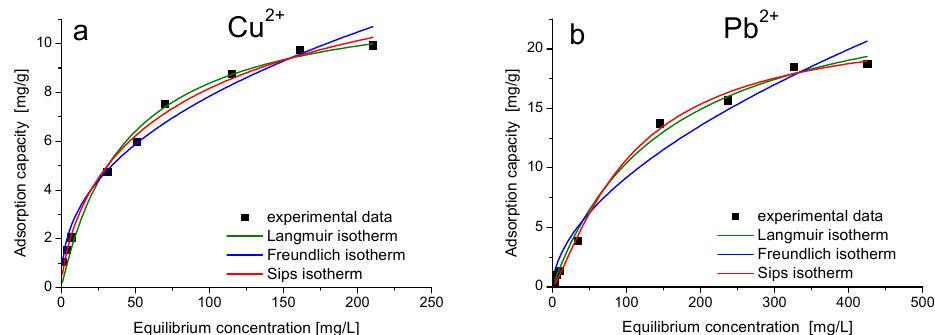
Figure 9. Adsorption isotherms of ( a ) Cu(II) on MeOE-75%-RT and ( b ) Pb(II) on MeOE-0%-RT.